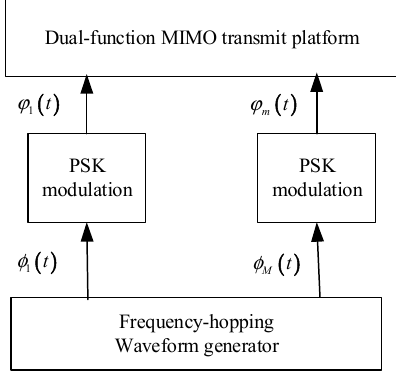
Figure 1. Illustrative diagram of a dual-function multiple-input multiple-output (MIMO) transmit Figure1. platform.